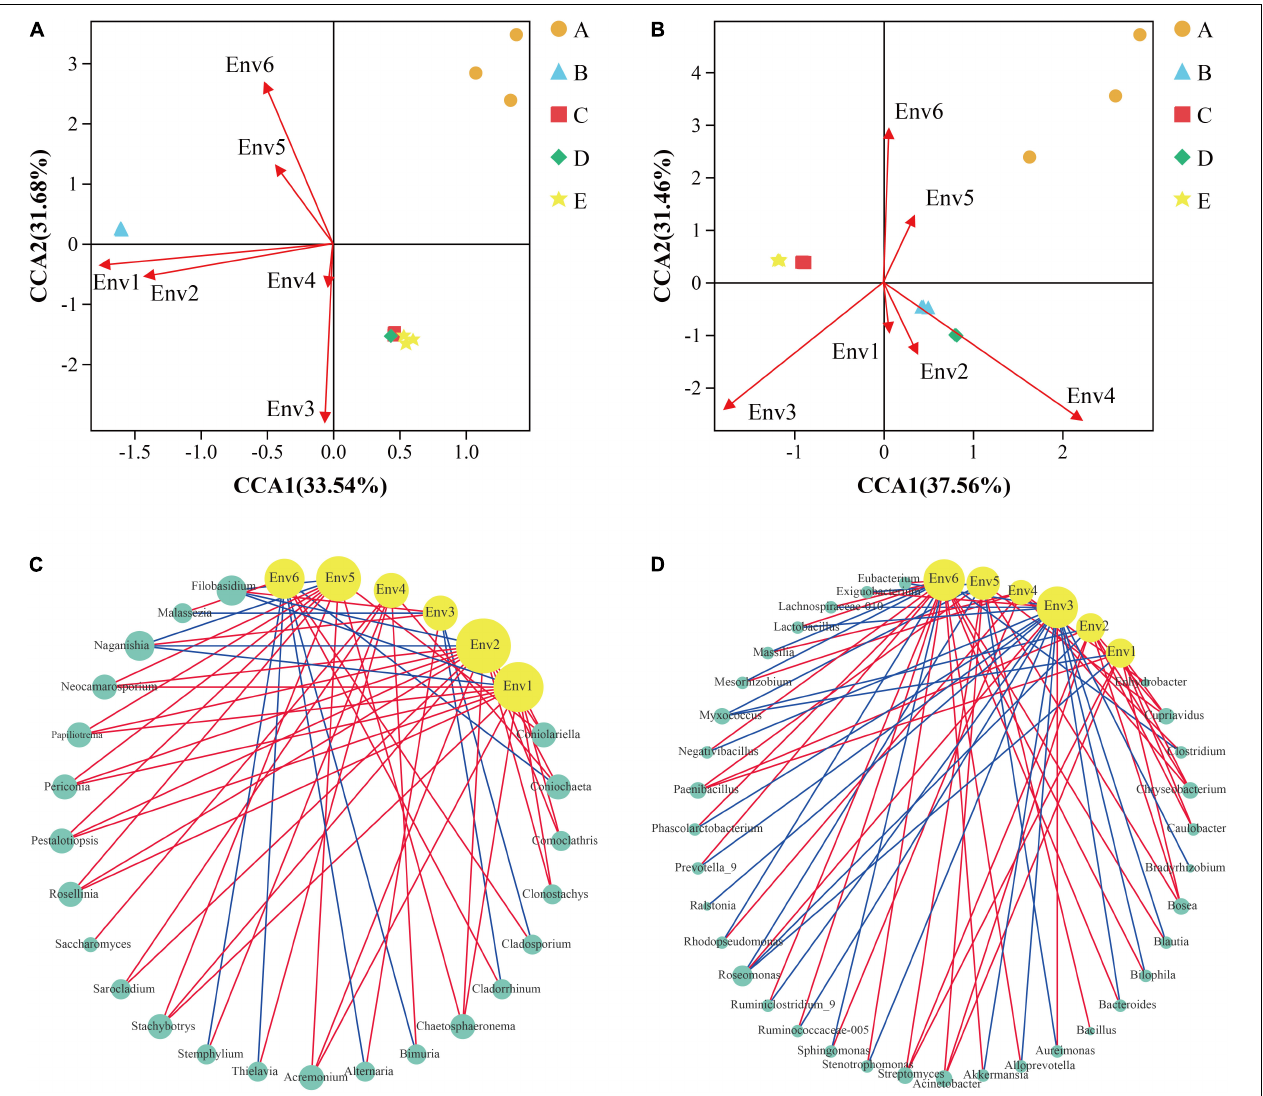
FIGURE 6 | Statistically correlation among grape microorganisms and vineyard weather was observed during grape development. CCA reflects the relationship between meteorological parameters and the diversity of fungi (A) and bacteria (B) during grape development. Network analysis reflected the co-occurrence relationship between the fungi (C) and bacteria (D) taxa and meteorological parameters. The yellow circular nodes represent meteorological parameters. The green circular nodes represent microbial taxa. Direct connections between nodes indicated strong correlations (Spearman correlation coefficient, r ≥ 0.5; p < 0.05). The color of the edges represents positive correlation (red) or negative correlation (blue). The size of the node is directly proportional to the degree of interconnection. Env1, average high temperature; Env2, average low temperature; Env3, relative humidity; Env4, precipitation; Env5, average ground temperature; Env6,